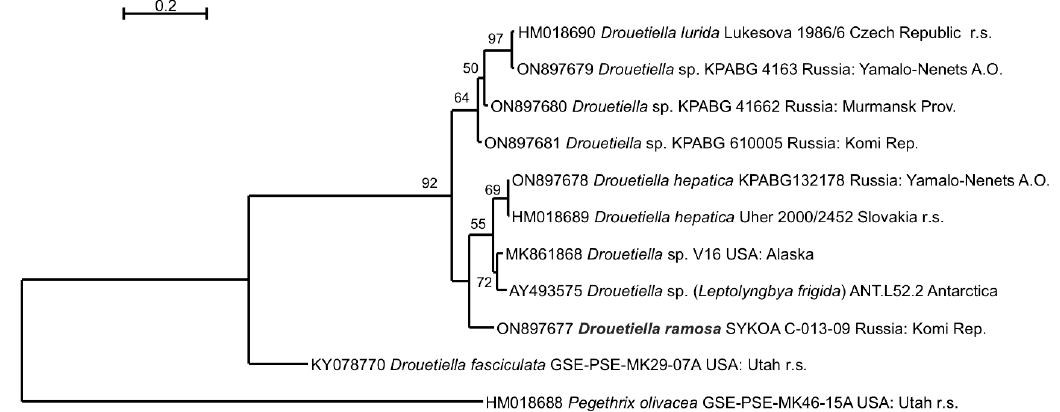
Figure 5. Phylogram obtained under the maximum likelihood approach for 10 accessions of Drouetiella based on the 16S-23S ITS region. Bootstrap support values of more than 50% are indicated.